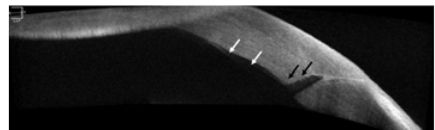
Figure2:ATDAS-OCTimagedemonstratinglocalizedDescemet’s membrane detachment (white arrow) adjacent to the wound and internal wound gaping (black arrow) that was not detected in slit- lamp examination.